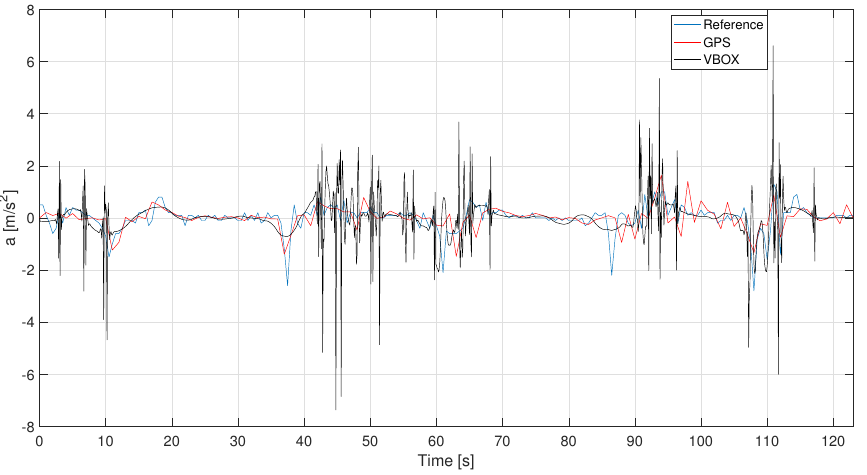
Figure 7. C1—Reference, GPS and VBOX acceleration